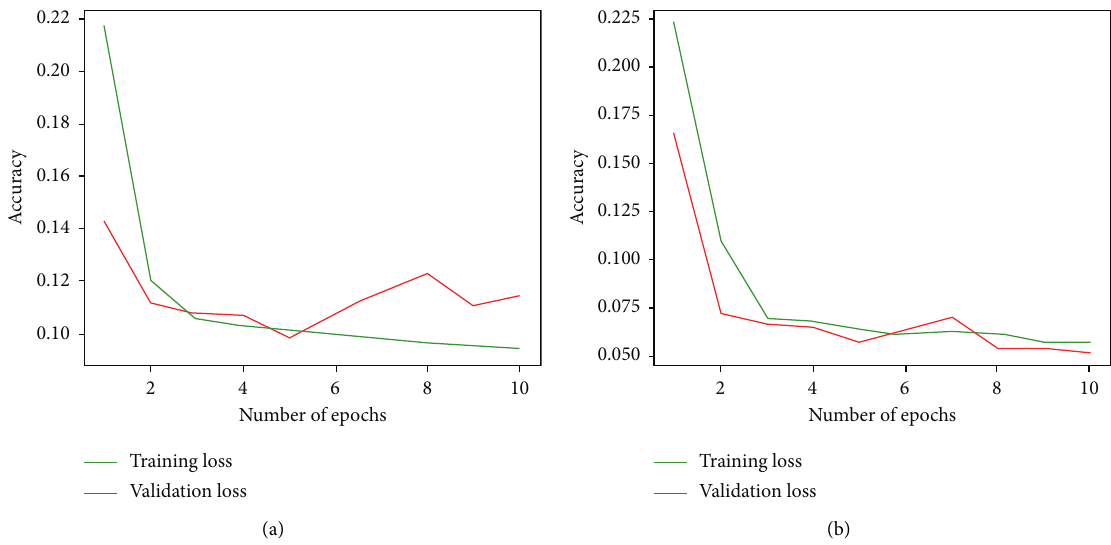
Figure 12: Training loss and epochs of (a) the convolution neural network (CNN) model and (b) the long short-term memory (LSTM) model.